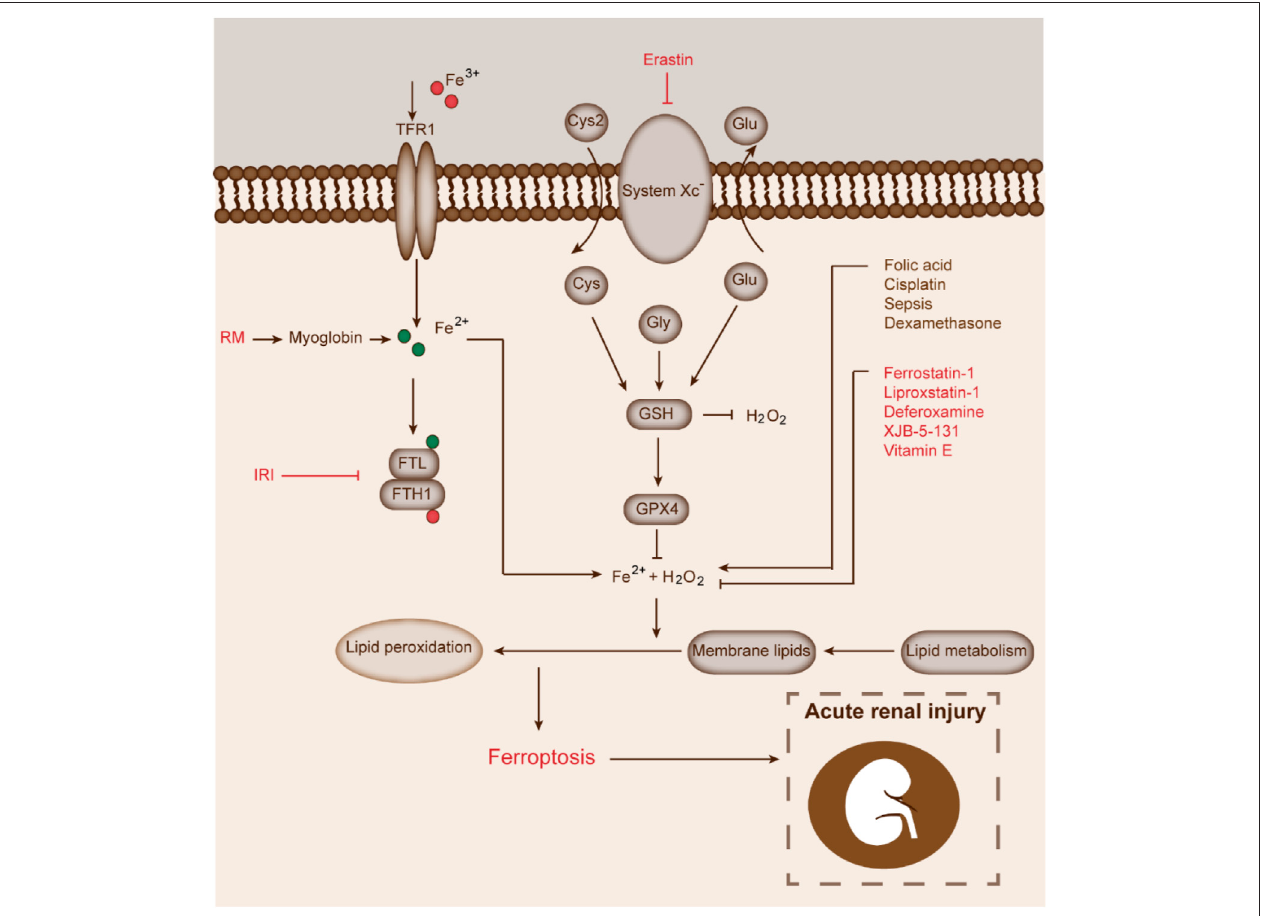
FIGURE 4 | Treatment of AKI by targeting ferroptosis of renal tubular epithelial cells. This fi gure shows that abnormal increase of Fe 2+ and H 2 O 2 promotes the Fenton chemical reaction and lipid peroxidation, and mediates ferroptosis, thus leading to AKI. RM initiates ferroptosis by increasing the levels of Fe 2+ ; IRI induces ferroptosis by suppressing the transformation of Fe 2+ to Fe 3+ . Other pathogenic factors such as FA, cisplatin, sepsis, and dexamethasone can also induce ferroptosis and lead to AKI. Ferrostatin-1, liproxstatin-1, deferoxamine, XJB-5-131, and vitamin E can alleviate or delay the development of AKI by inhibiting ferroptosis.